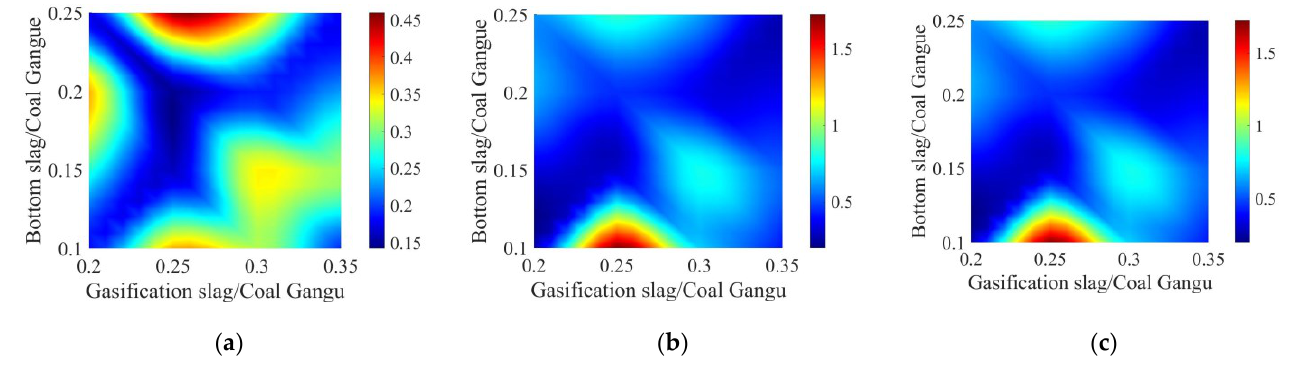
Figure 13. Influence of C and D factors on compressive strength of different curing ages. ( a ) 3 d UCS; ( b ) 7 d UCS; ( c ) 28 d UCS.